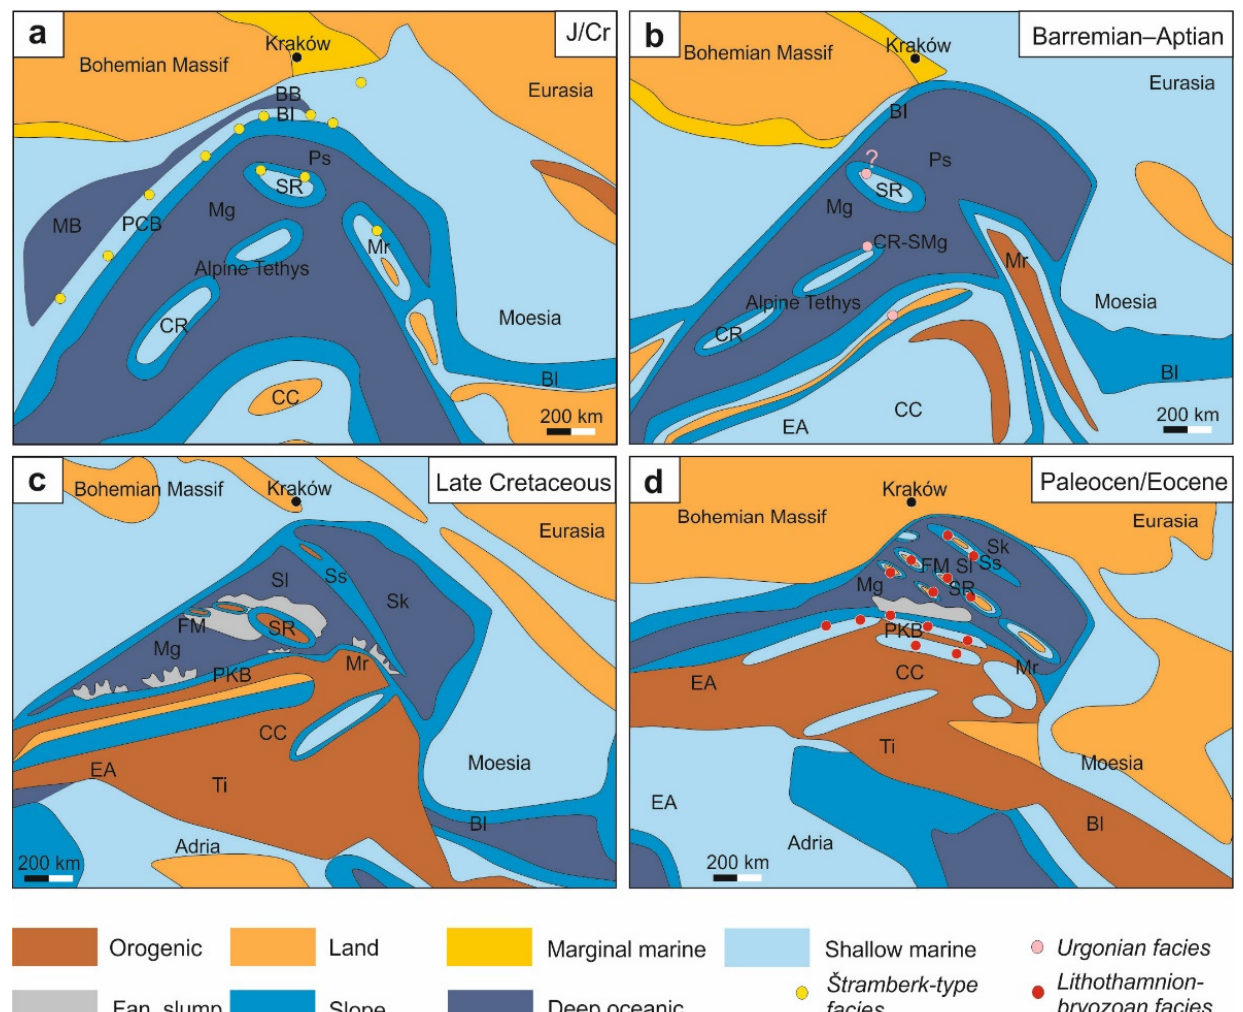
Figure 6. Palaeogeography of the Outer Carpathian Tethys and adjacent areas with the approximate position of the carbonate platforms: ( a ) Latest Jurassic–Early Cretaceous; ( b ) Barremian–Aptian; ( c ) Late Cretaceous, ( d ) Eocene. Abbreviations: BB = Bachowice Basin, BI = Baška-Inwałd Ridge, Bl = Balcans, CC = Central Carpathians, CR = Czorsztyn Ridge, CR-SMg = South Magura Ridge (the most presumable northeastern prolongation of the Czorsztyn Ridge), EA = Eastern Alps, FM = Foremagura Ridge and Basin, MB = Mikulov Basin, Mg = Magura Basin, Mr = Marmarosh Ridge, PCB = Pavlov Carbonate Platform, PKB = Pieniny Klippen Belt, PS = Protosilesian Basin, SK = Skole Basin, Sl = Silesian Basin, SR = Silesian Ridge, Ti = Tisza, ?—presumable (poorly documented) occurrence.